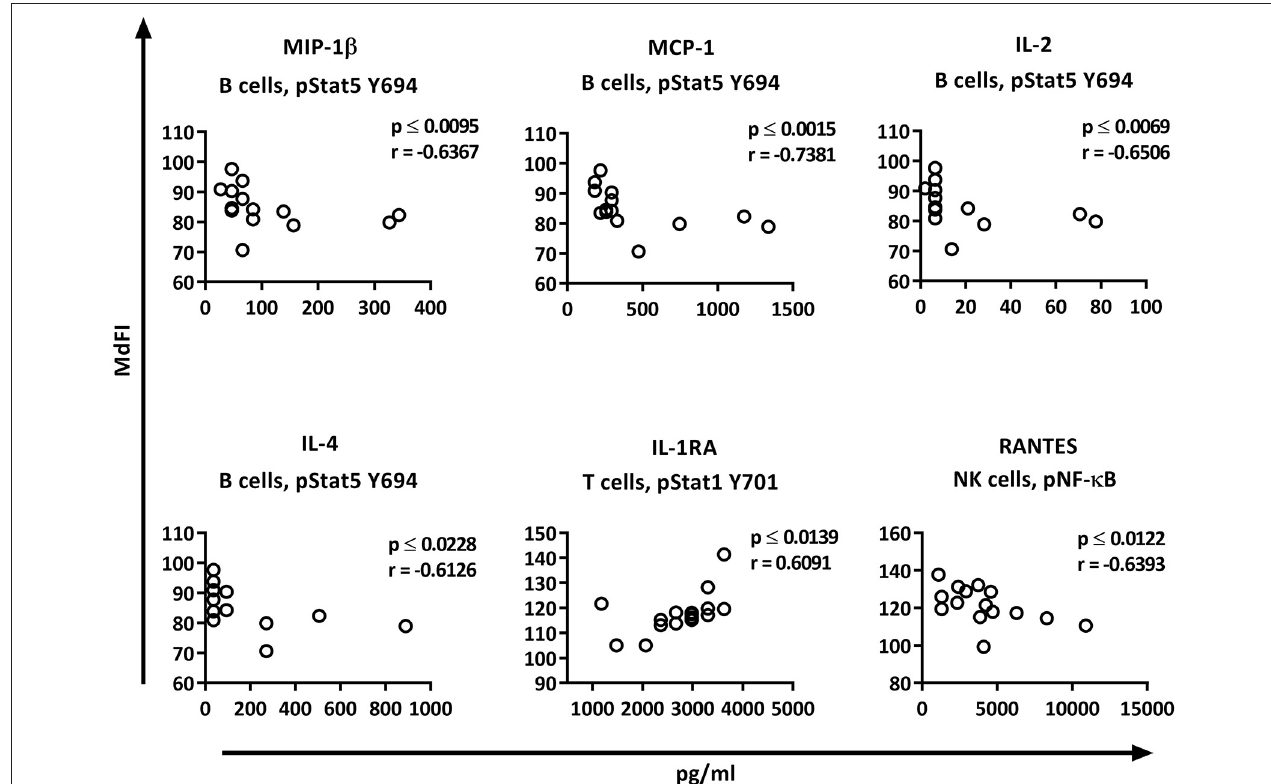
FIGURE 7 | Correlations of basal phosphorylation profiles with plasma cytokine levels in pSS patients without medication. Correlations were assessed by Spearman’s rank test. Strong ( r = 0.6–0.79) to very strong ( r = 0.8–1.0) associations are shown with respective p and r -values given at the side of each graph. Correlations were considered statistically significant for p ≤ 0.05. X-axis denotes concentration of cytokines (pg/ml) and Y-axis denotes phosphorylation levels (MdFI). The data represents pSS patients ( n = 16) without medication (except for IL-4, n = 14, and RANTES, n =